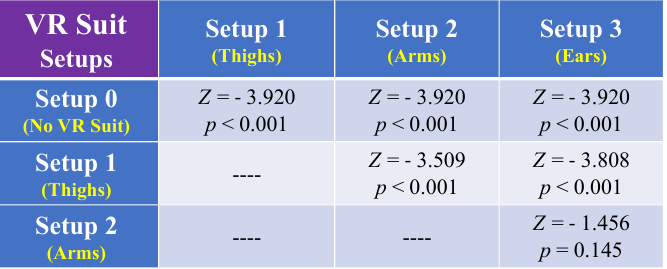
Figure 6. Wilcoxon test results on differences in average task completion times between each pair of setups.